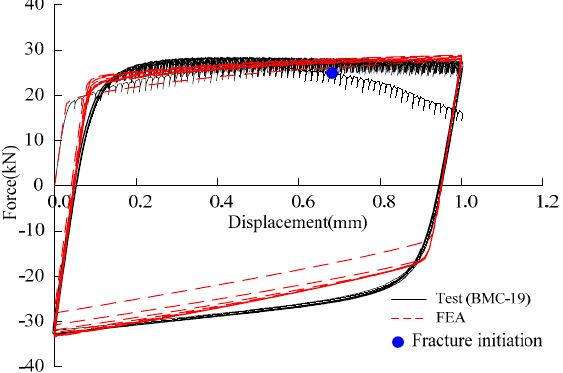
Figure 11. Comparison of force-displacement curve obtained by tests and FEA under cyclic loading.